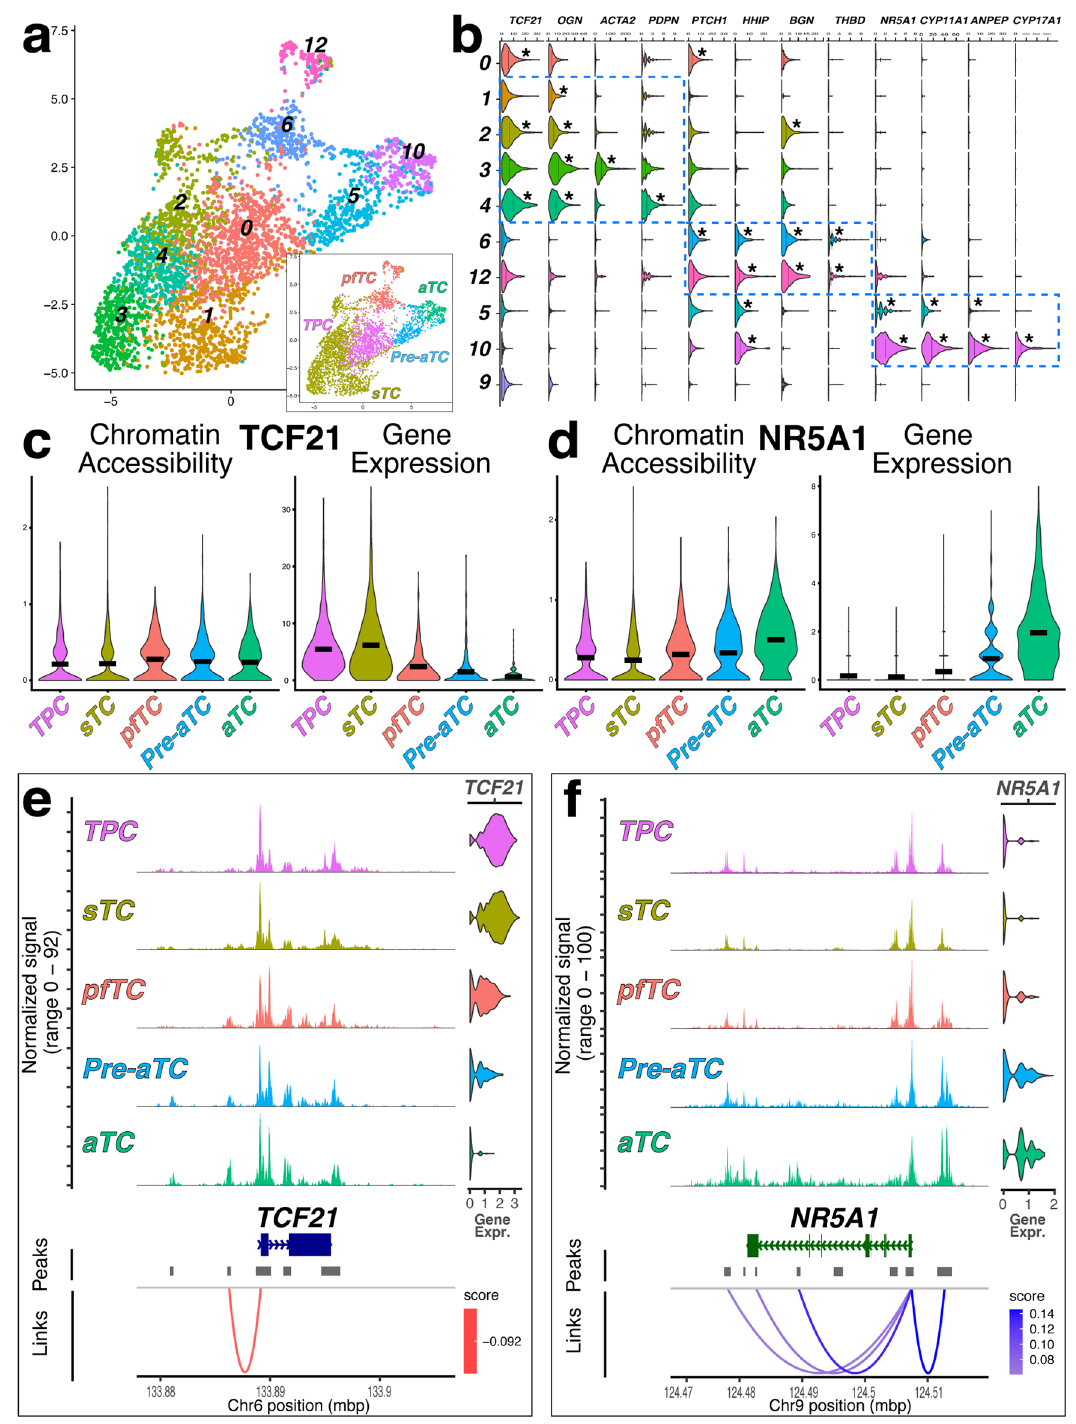
Fig. 5 Combined snRNASeq and scATACSeq reveals reciprocal accessibility of the NR5A1 and TCF21 genomic loci as cells differentiate. a – b Designation of theca/stroma subclusters based on snRNASeq using previously identi fi ed referents; UMAP graphs in ( a ) show Seurat clusters with groups redesignated in the inset based on markers of theca subpopulations shown in violin plots in ( b ); each population is demarcated by dotted blue lines. c – d Violin plots showing overall chromatin accessibility and RNA expression by theca/stroma subtype for the TCF21 ( c ) and NR5A1 ( d ) locus. e – f Sequencing tracks, snRNA Expression data and predicted regulation of chromatin accessibility peaks to gene expression for the TCF21 ( e ) and NR5A1 ( f ) locus, by theca subtype. Positive interactions are depicted in blue and negative interaction are depicted in red. b – d Lines in violin plots indicate mean expression level; asterisks indicate signi fi cant enrichment of a transcript relative to all other Seurat clusters ( p value ≤ 1 × 10 − 43 ).